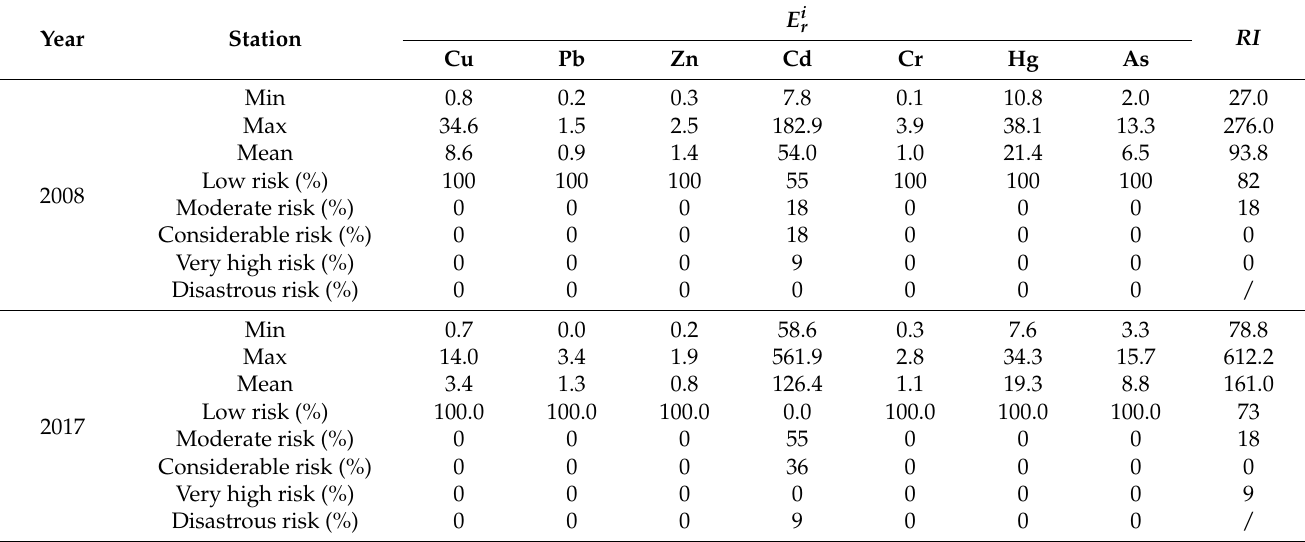
Table 4. Potential ecological risks for heavy metals in the surface sediment of Weitou